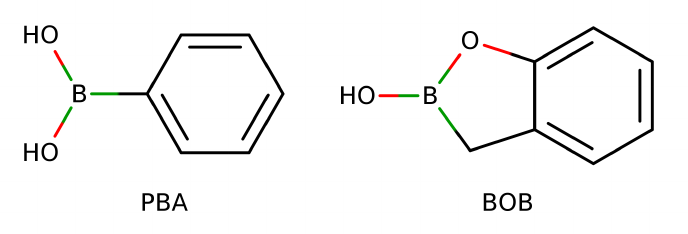
Figure 13. Phenyl Boronic Acid (PBA) and Benzoxaborole (BOB)